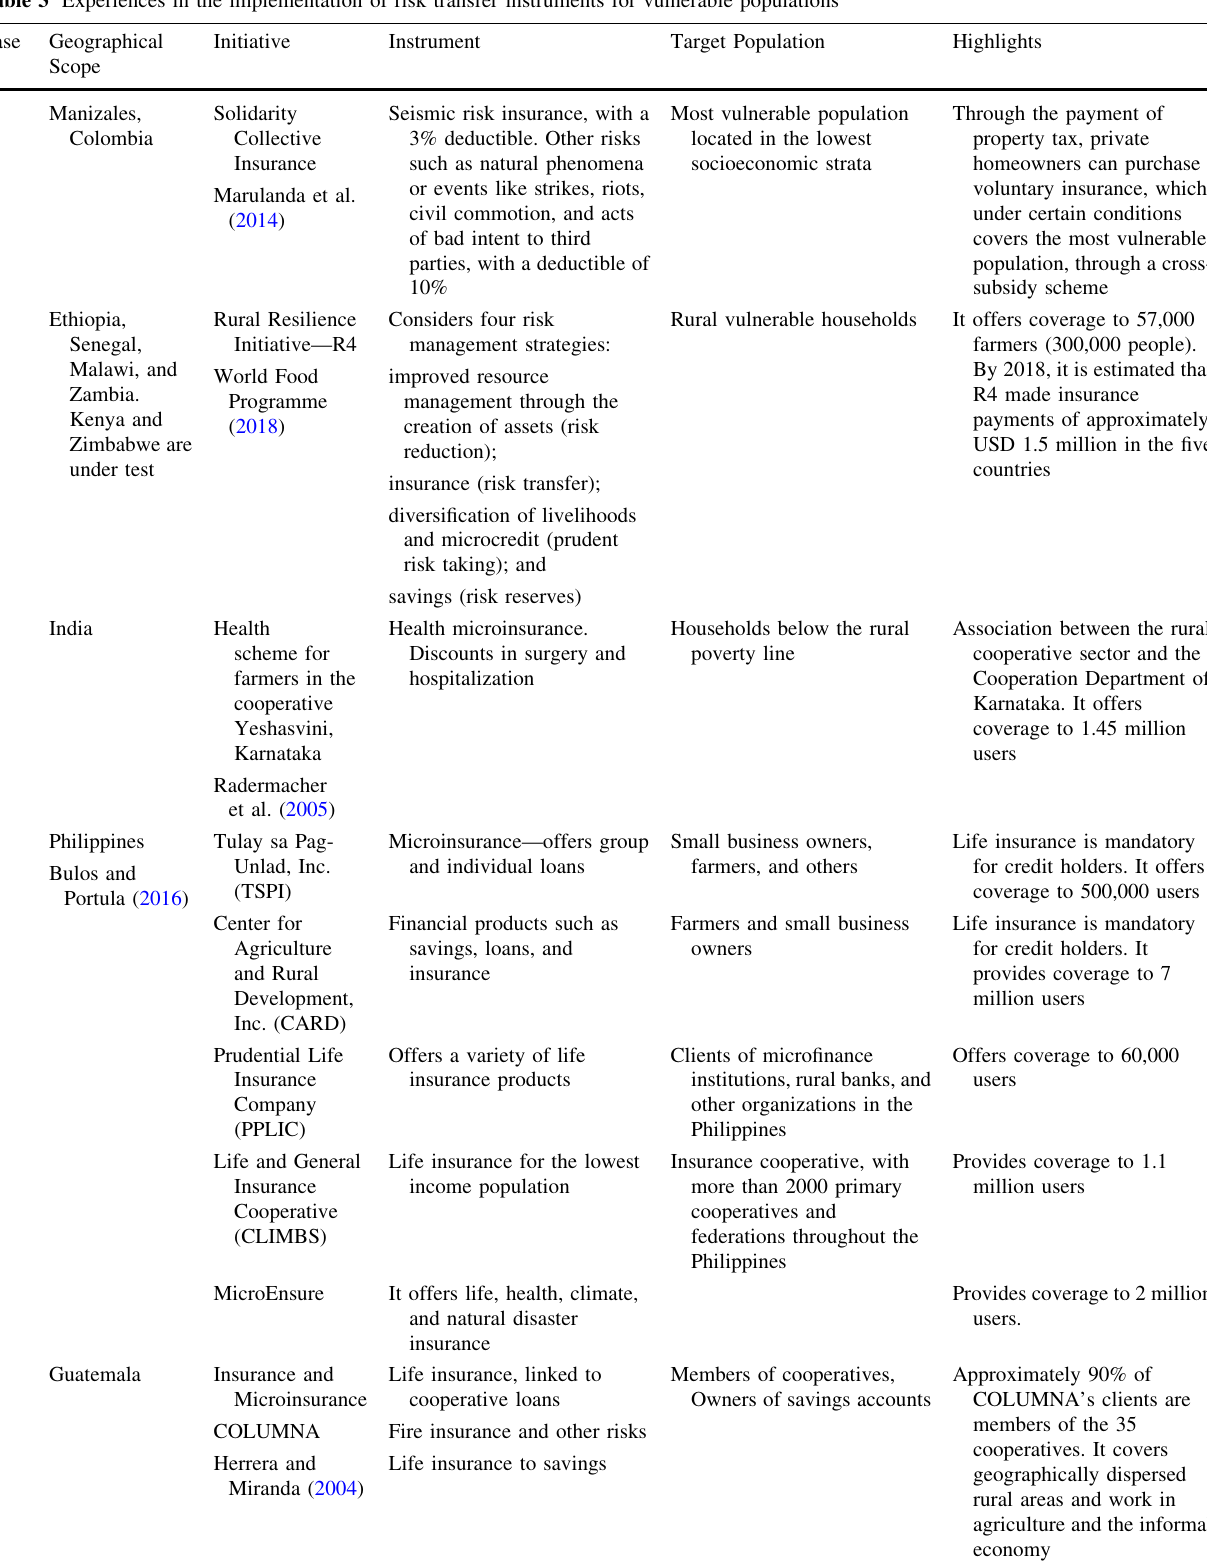
Table 3 Experiences in the implementation of risk transfer instruments for vulnerable